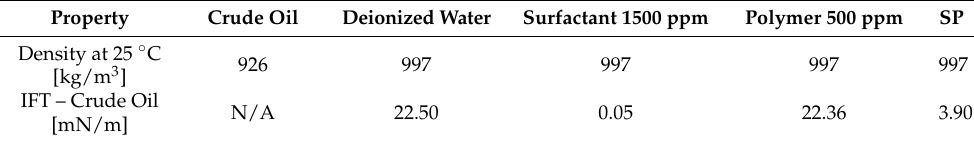
Table 1. Properties of the oil and aqueous solutions used in this